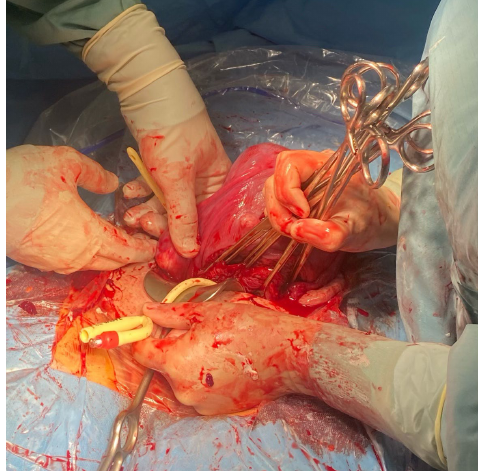
Figure 5. The assistant tightens the Foley catheter. Figure 6. The assistant fixes the Foley catheter with Kocher forceps.